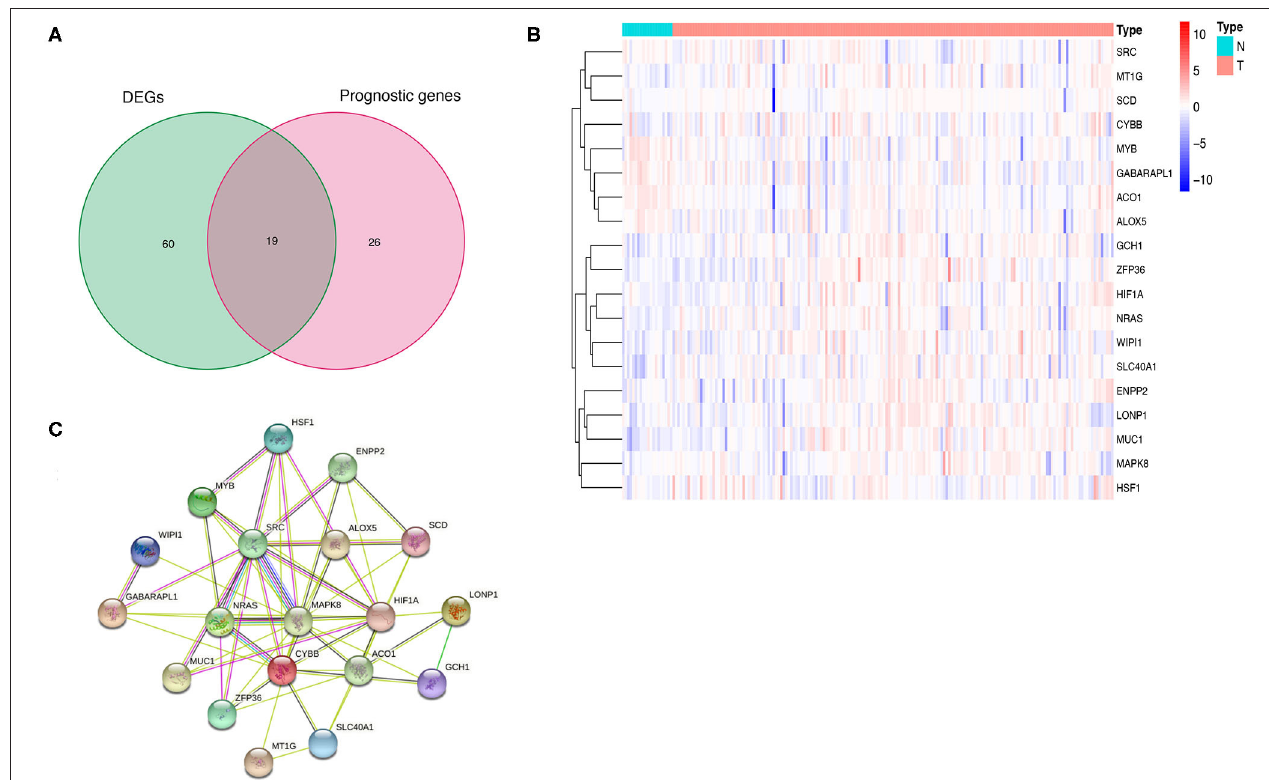
FIGURE 3 | Identification and expression of the overlapping genes between DEGs and prognostic genes in IPF. (A) Venn diagram of 19 overlapping genes. (B) Expression of the 19 overlapping genes in IPF. (C) The correlation network of the overlapping genes. IPF, idiopathic pulmonary fibrosis; DEGs, differentially expressed genes; PPI, protein–protein